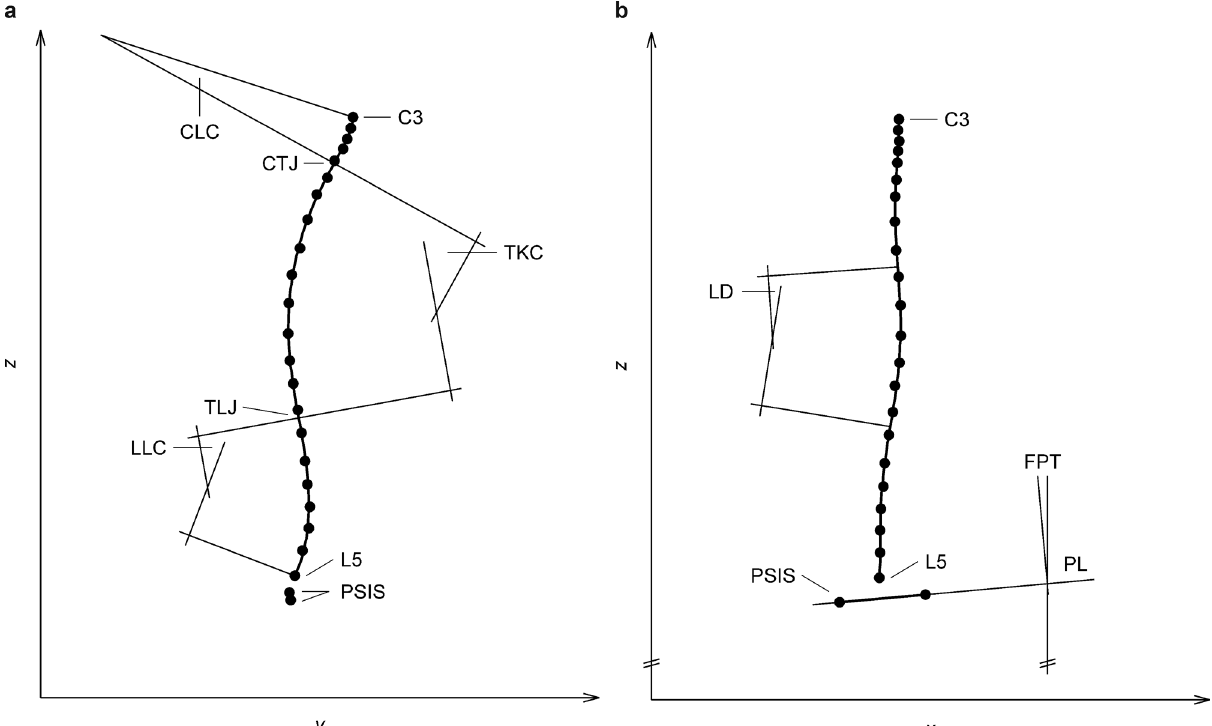
Figure 1. Definition of spinal shape variables in the sagittal plane – the right view (a) and the frontal plane – the back view (b). C3 = spinous process of the vertebra C3; CLC = cervical lordosis curvature; CTJ = cervicotho- racic junction; FPT = frontal pelvic tilt; L5 = spinous process of the L5 vertebra; LLC = lumbar lordosis curvature; PSIS = posterior superior iliac spine; PL = pelvic line connecting the left and right PSIS; LD = lateral deviation; TKC = thoracic kyphosis curvature; TLJ = thoracolumbar